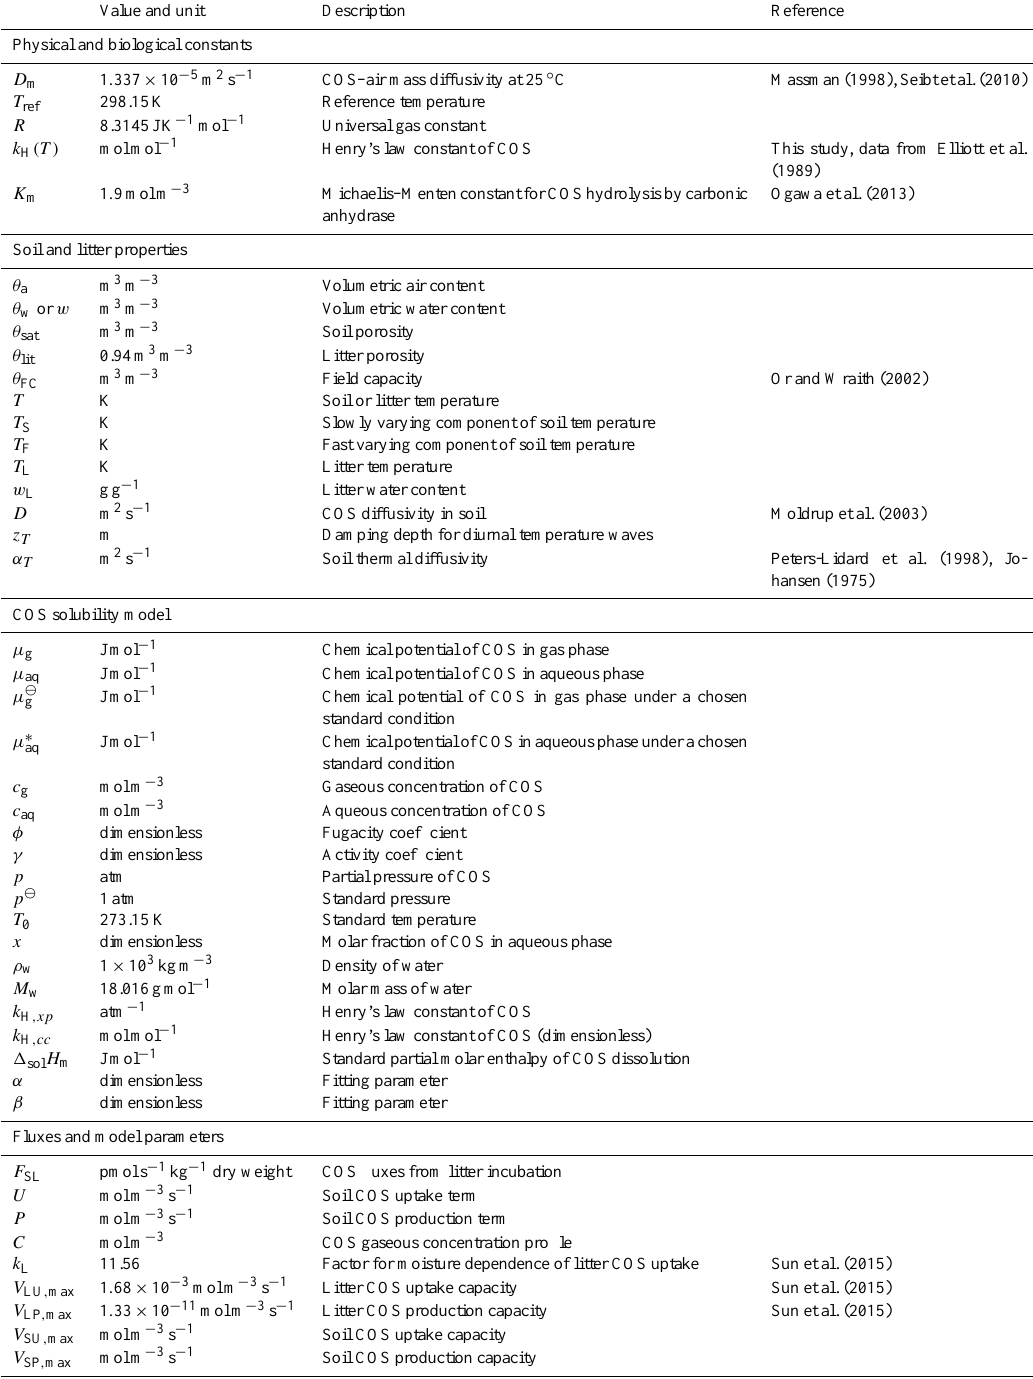
Table A1. List of variables and